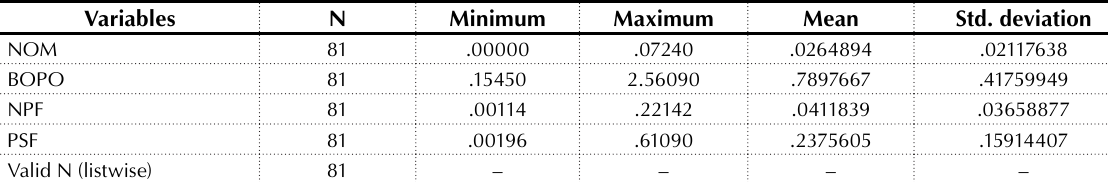
Table 1. Descriptive statistic for main variables